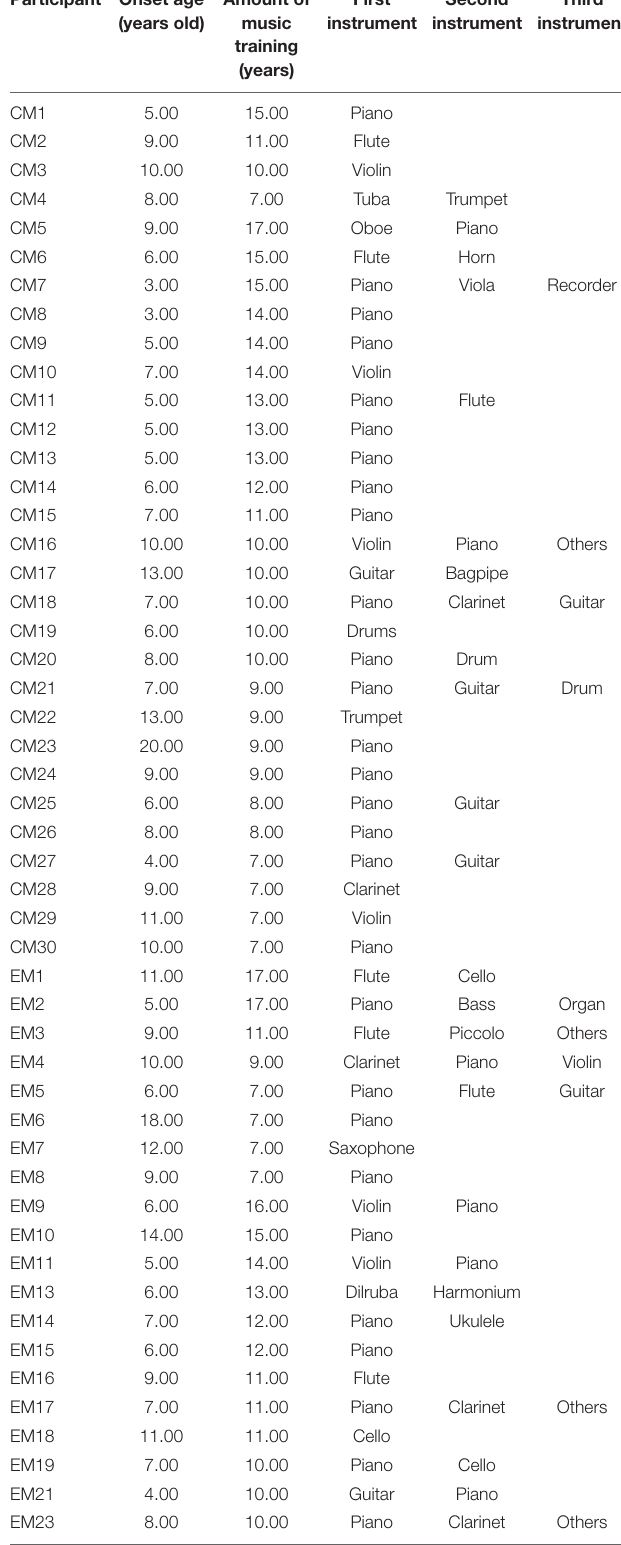
TABLE 3 | Musical experience of the